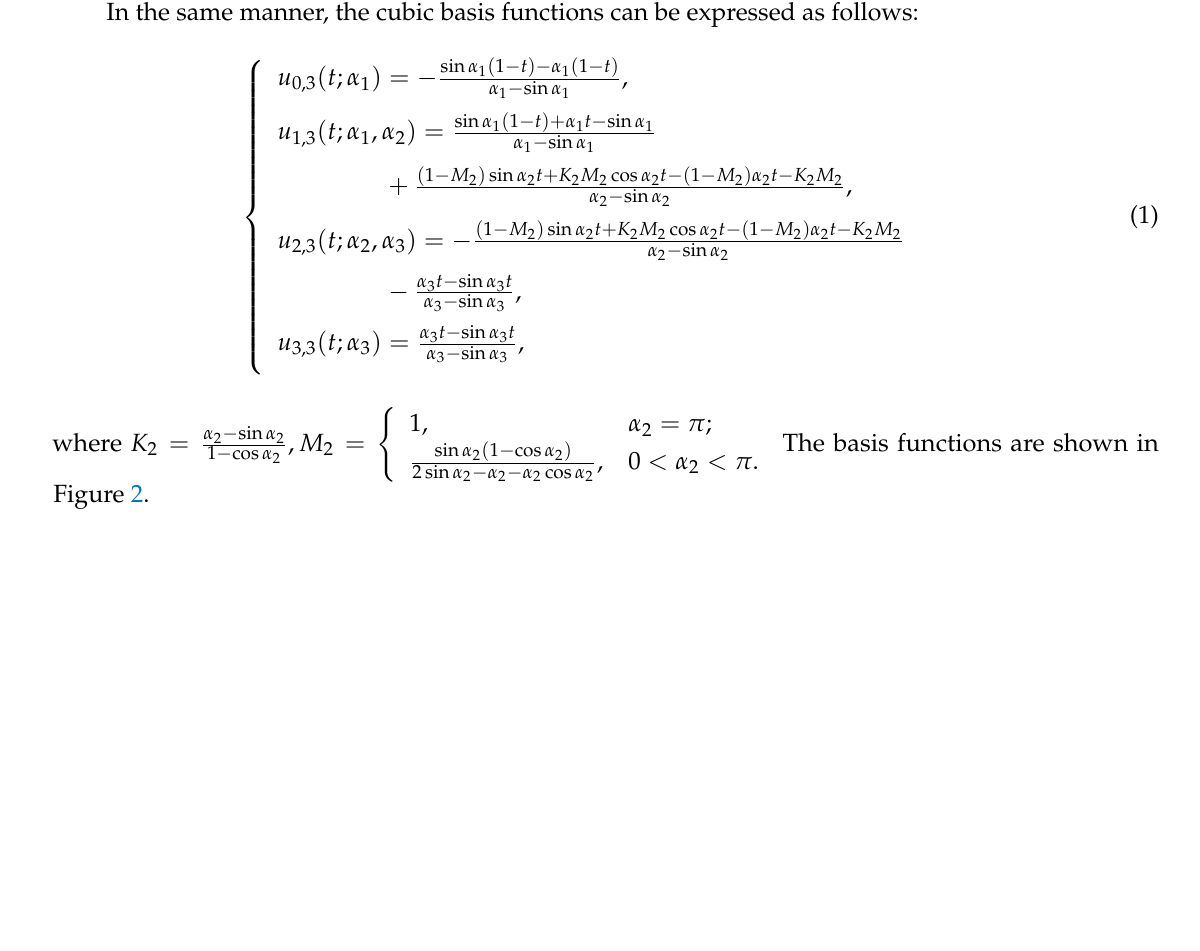
Figure 1. Quadratic basis functions. ( a ) α 1 = π ( d ) α 1 = 7 π